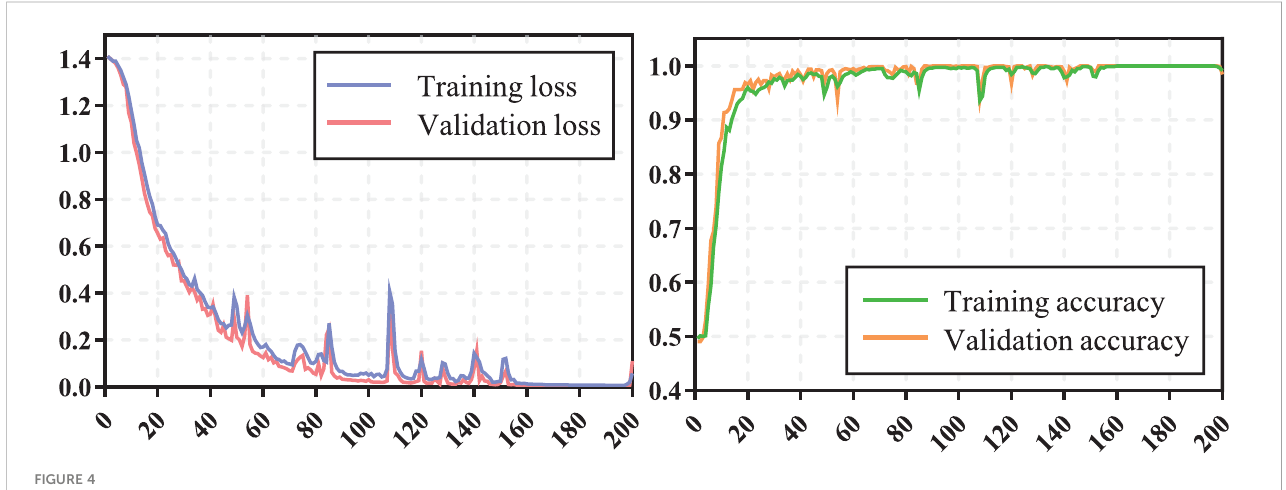
FIGURE 4 The training process of transformer